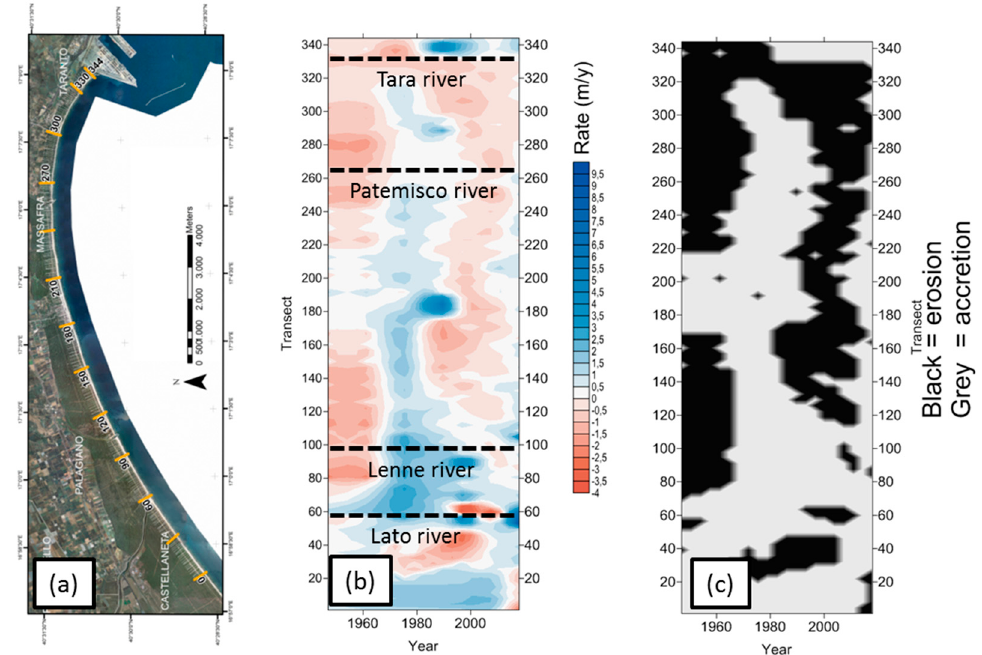
Figure 10. Shoreline evolution of the investigated sandy coast: ( a ) Map with transects; ( b ) shoreline change rates (red indicates the erosion, while blue, the accretion); and ( c ) shoreline changes: grey indicates the advancements, while black the retreats.